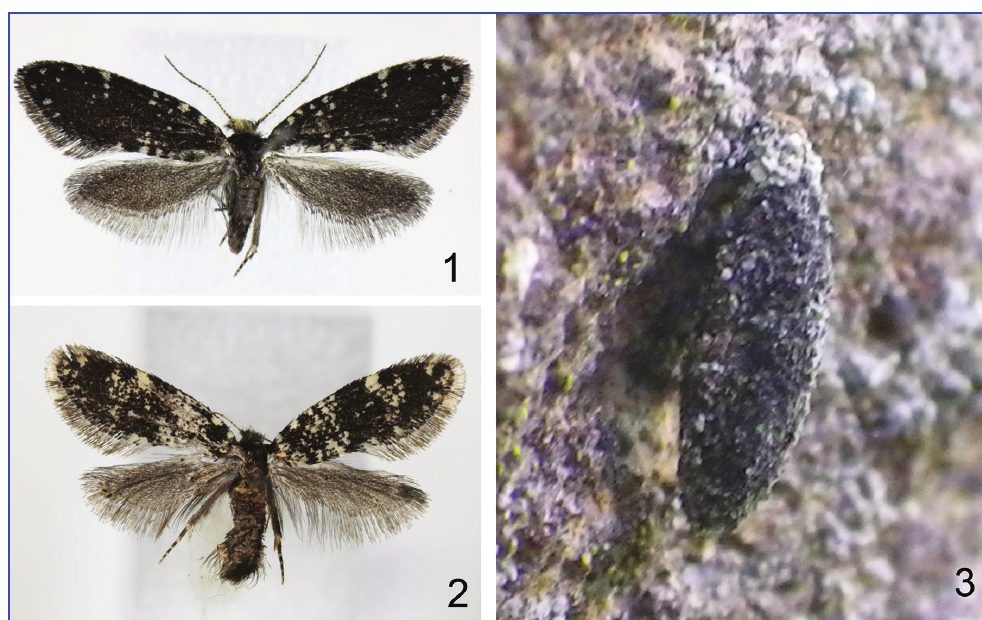
Figures 1–3. Narycia emikoae Niitsu, Jinbo & Nasu, sp. n. 1. Paratype male from Yunomaru. 2. Paratype female from Yunomaru. 3. Larval